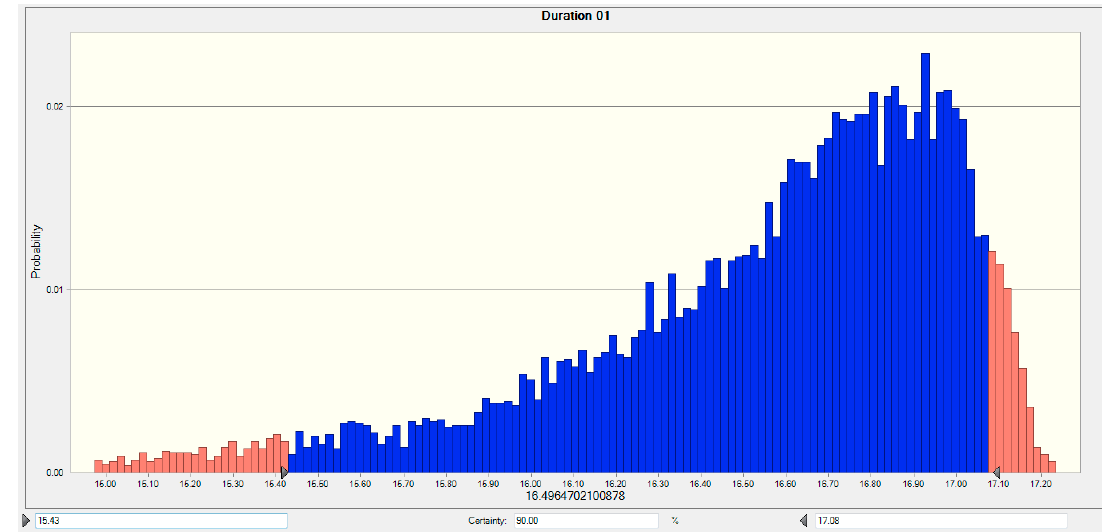
Figure 5. The Duration distribution with the changes in discount rate.